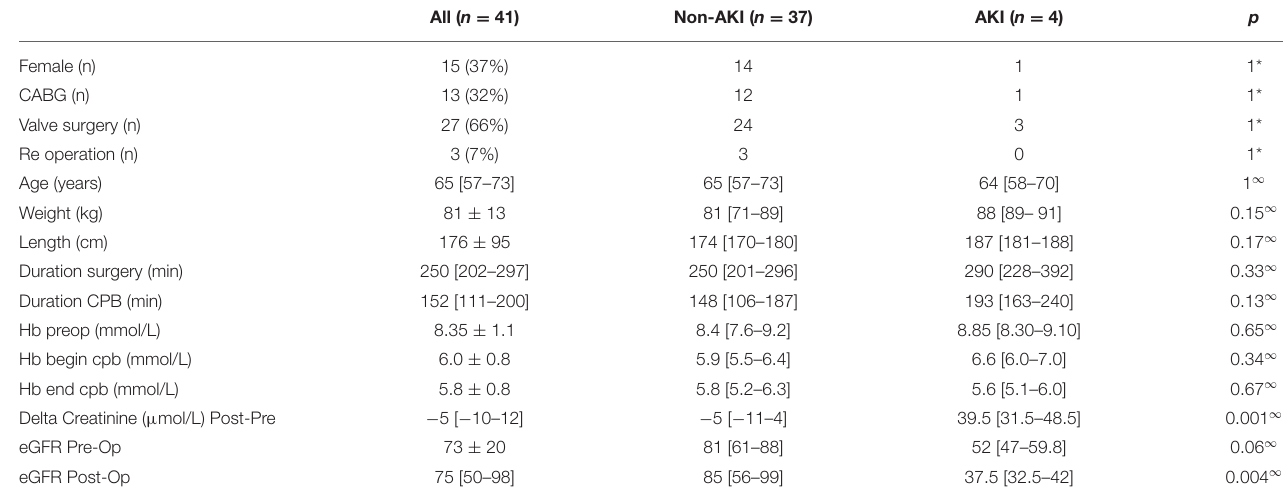
TABLE 1 | Patient